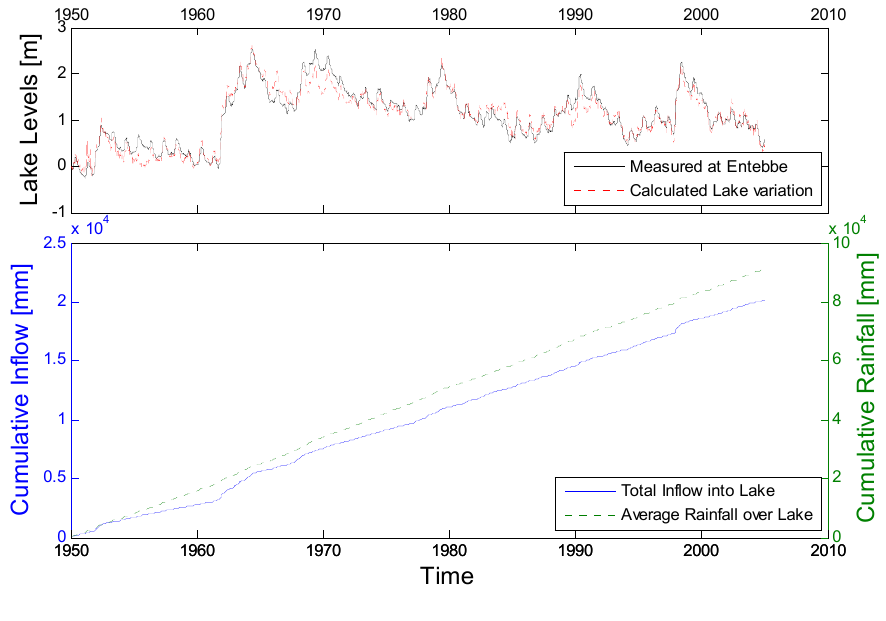
Figure 2. Lake level variations over time compared to cumulative average precipitation over the lake and cumulative total inflow into the lake. The calculated lake level variations are based on the precipitation and inflow